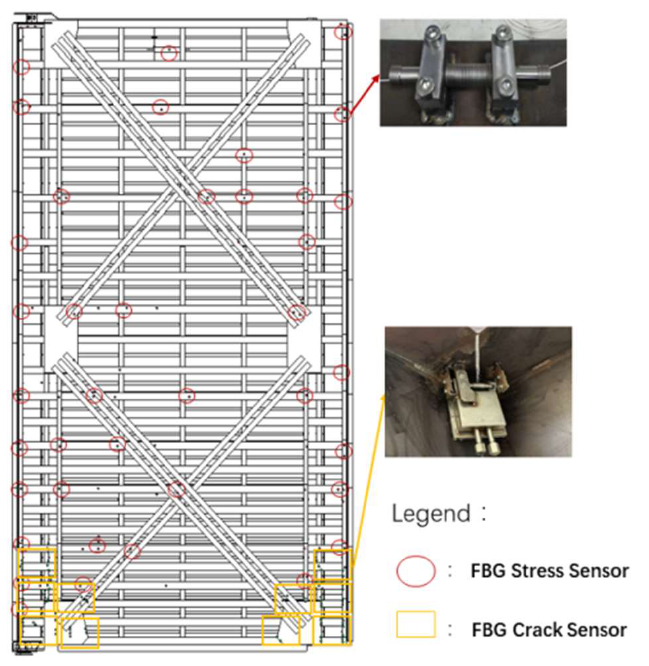
Figure 3. Layout of sensors on miter gate.